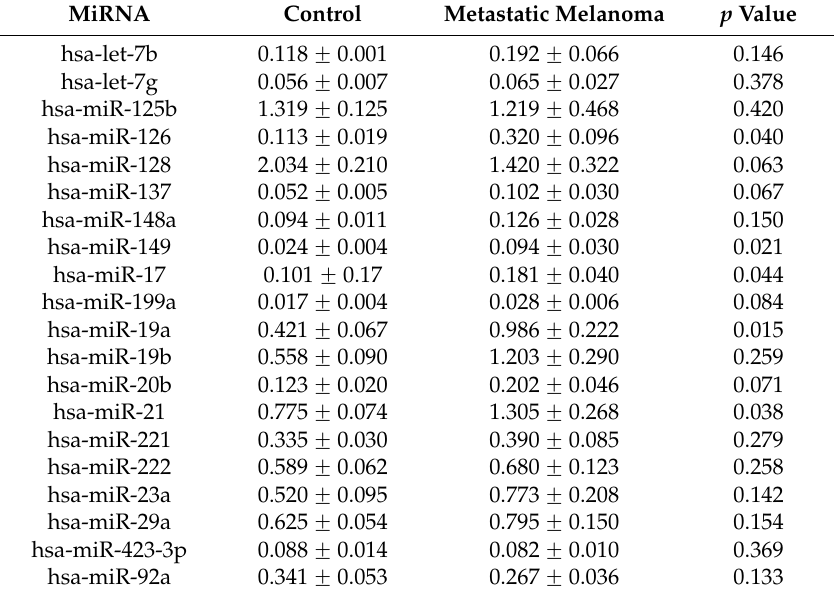
Table 5. MiRNA expression in plasma-derived exosomes from patients with metastatic